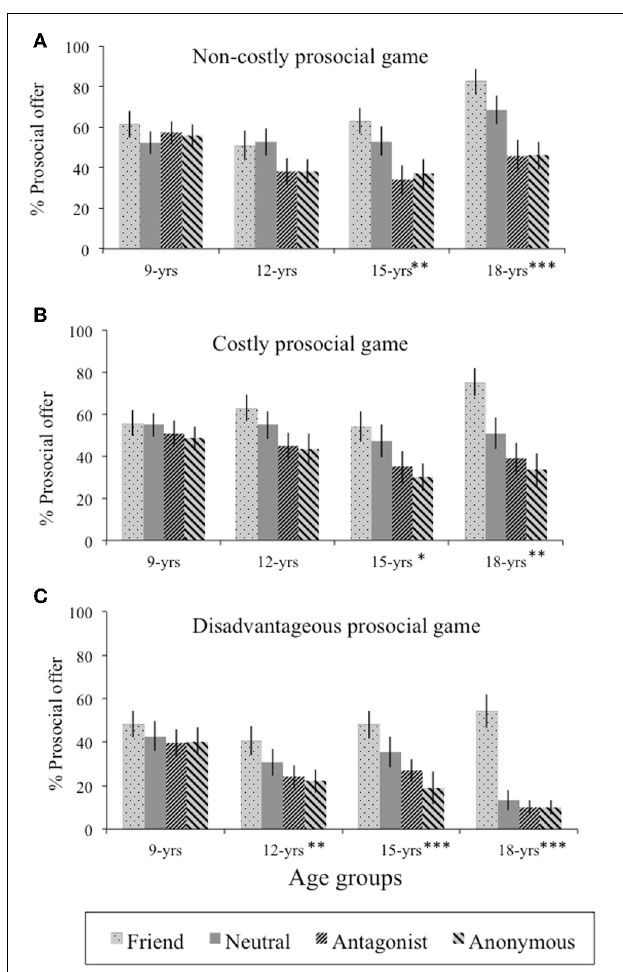
FIGURE 3 | Prosocial behavior in the allocation games. Mean frequency (%) and standard errors of prosocial offers [i.e., (1/1) distribution in the (A) Non-costly prosocial game and the (B) Costly prosocial game and (1/2) distribution in the (C) Disadvantageous prosocial game ] are presented per interaction partner for the four age groups. Age differences are indicated by an asterisk ( ∗ ). ∗ p < 0 . 05, ∗∗ p < 0 . 01, ∗∗∗ p < 0 .